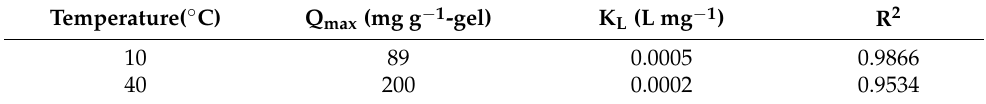
Table 1. Langmuir model parameters for As(III) adsorption in D-Mn gel.